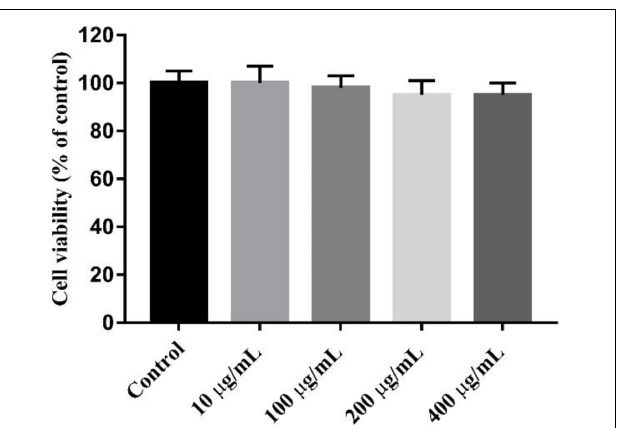
FIGURE 8 | Cytotoxicity of K-CMLP in RAW 264.7 macrophages at the different concentration (10, 100, 200, 400 µ g/mL).